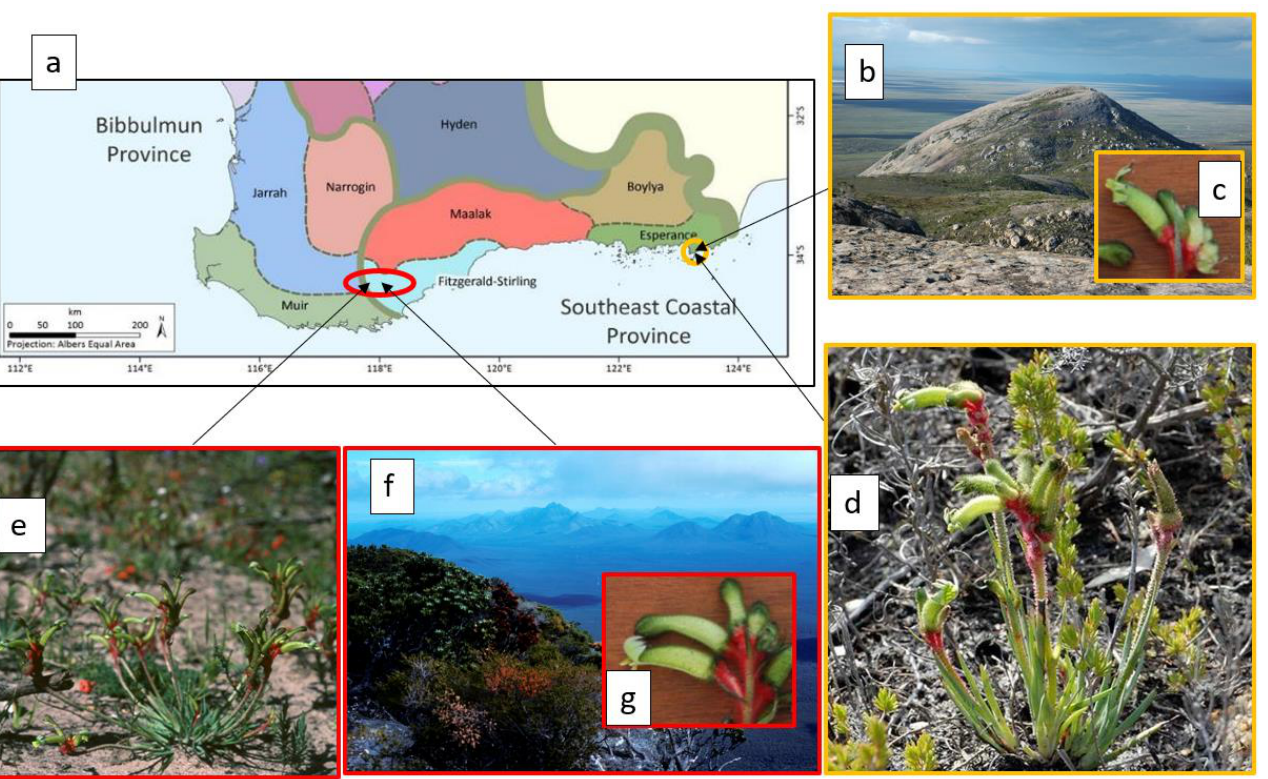
Figure 2. The sister species Anigozanthos yorlining Hopper ms and A . gabrielae Domin: ( a ) distribu- tions in the context of floristic provinces and regions and districts from Gioia and Hopper (2017); ( b – d ) A. yorlining at granite OCBIL Mt Arid; ( e – g ) A. gabrielae plains adjacent Stirling Range OCBIL quartzites. Photos S.D. Hopper.